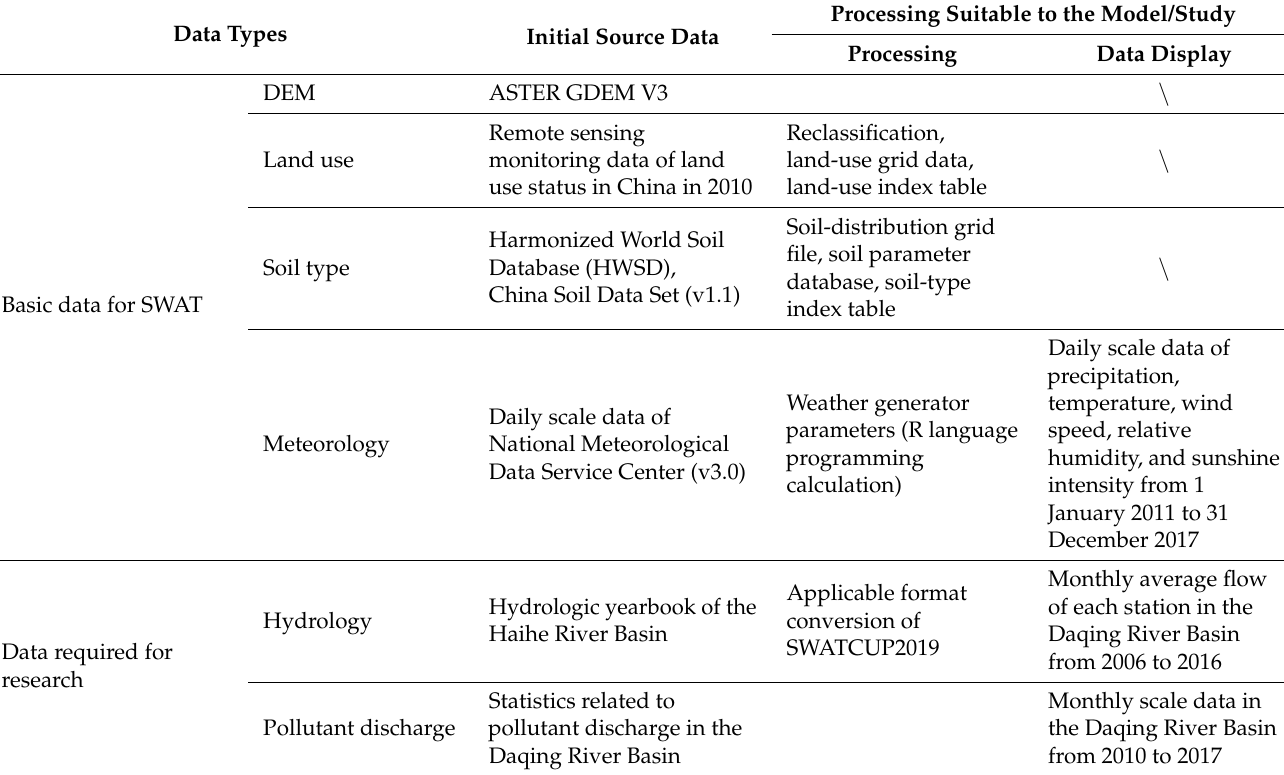
Table 1. Data sources and